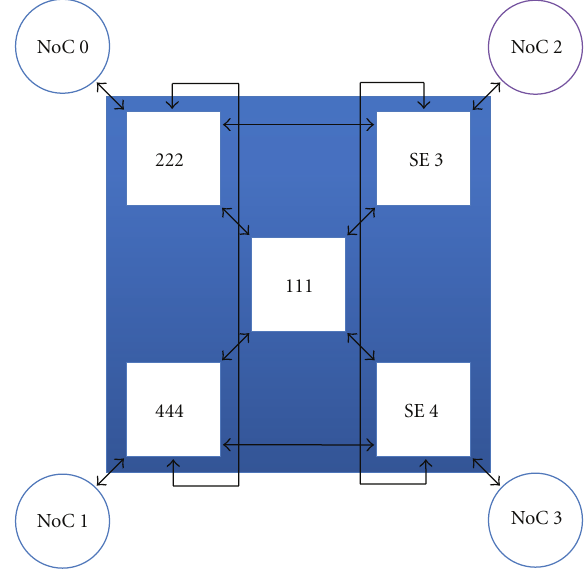
Figure 9: The simulation state of NiP-PNN model at second step of best